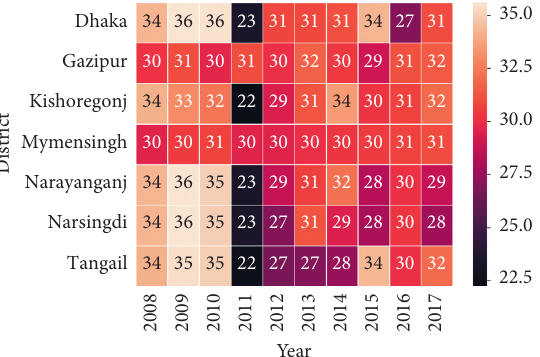
Figure 1: Analysis of maximum temperature from 2008 to 2017 against